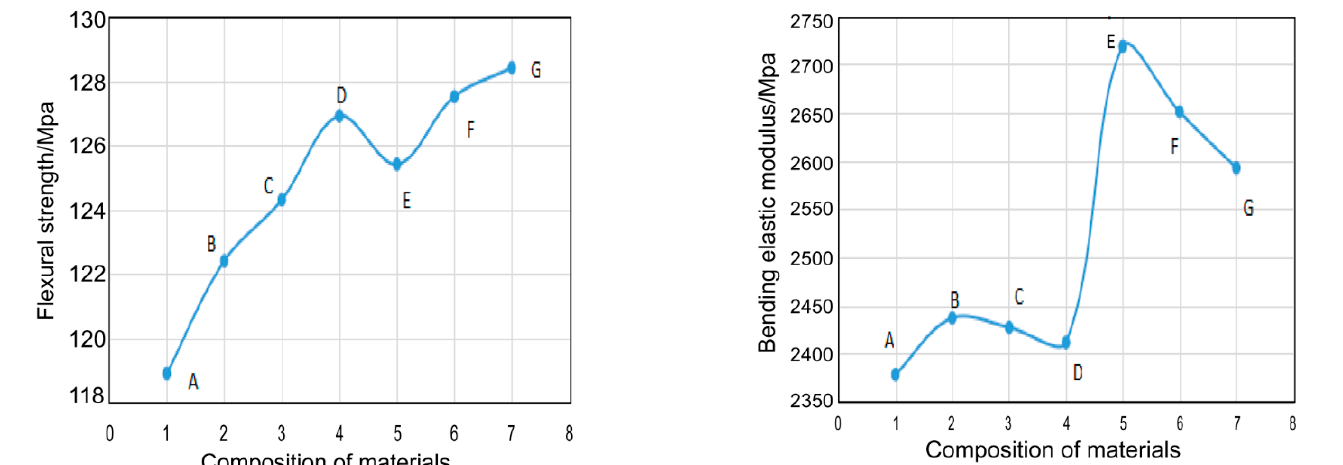
Nanomaterials 2021 , 11 , x FOR PEER REVIEW 10 of 12 Figure 10. The bending strength ( left ) and modulus ( right ) curves of different material systems for A: EP, B: EP-POSS-L, C: EP-POSS-M, D: EP-POSS-H, E: EP-SiO2-POSS-L, F: EP-SiO2-POSS-M, and G: EP-SiO2-POSS-H.